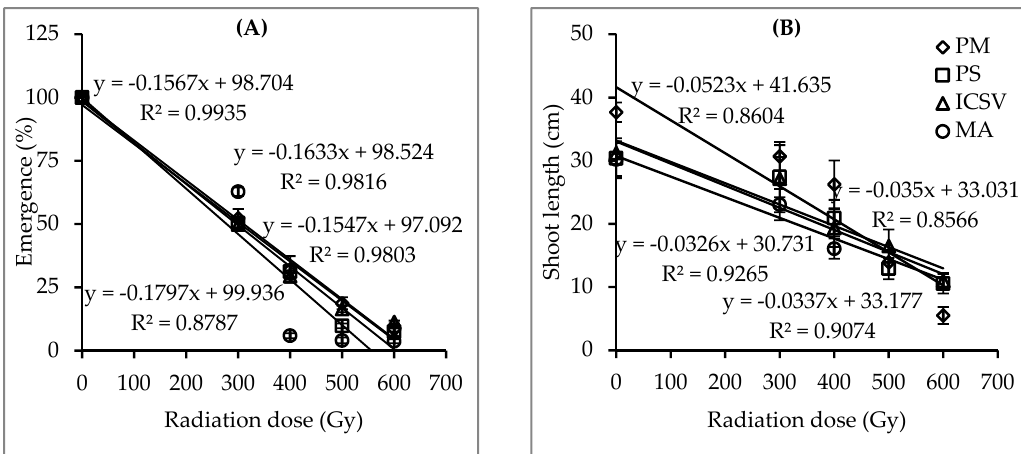
Figure 1. Emergence percentage ( A ) and shoot length ( B ) and fitted straight lines of four sorghum genotypes treated with five gamma radiation doses in experiment I (bars represent standard error).